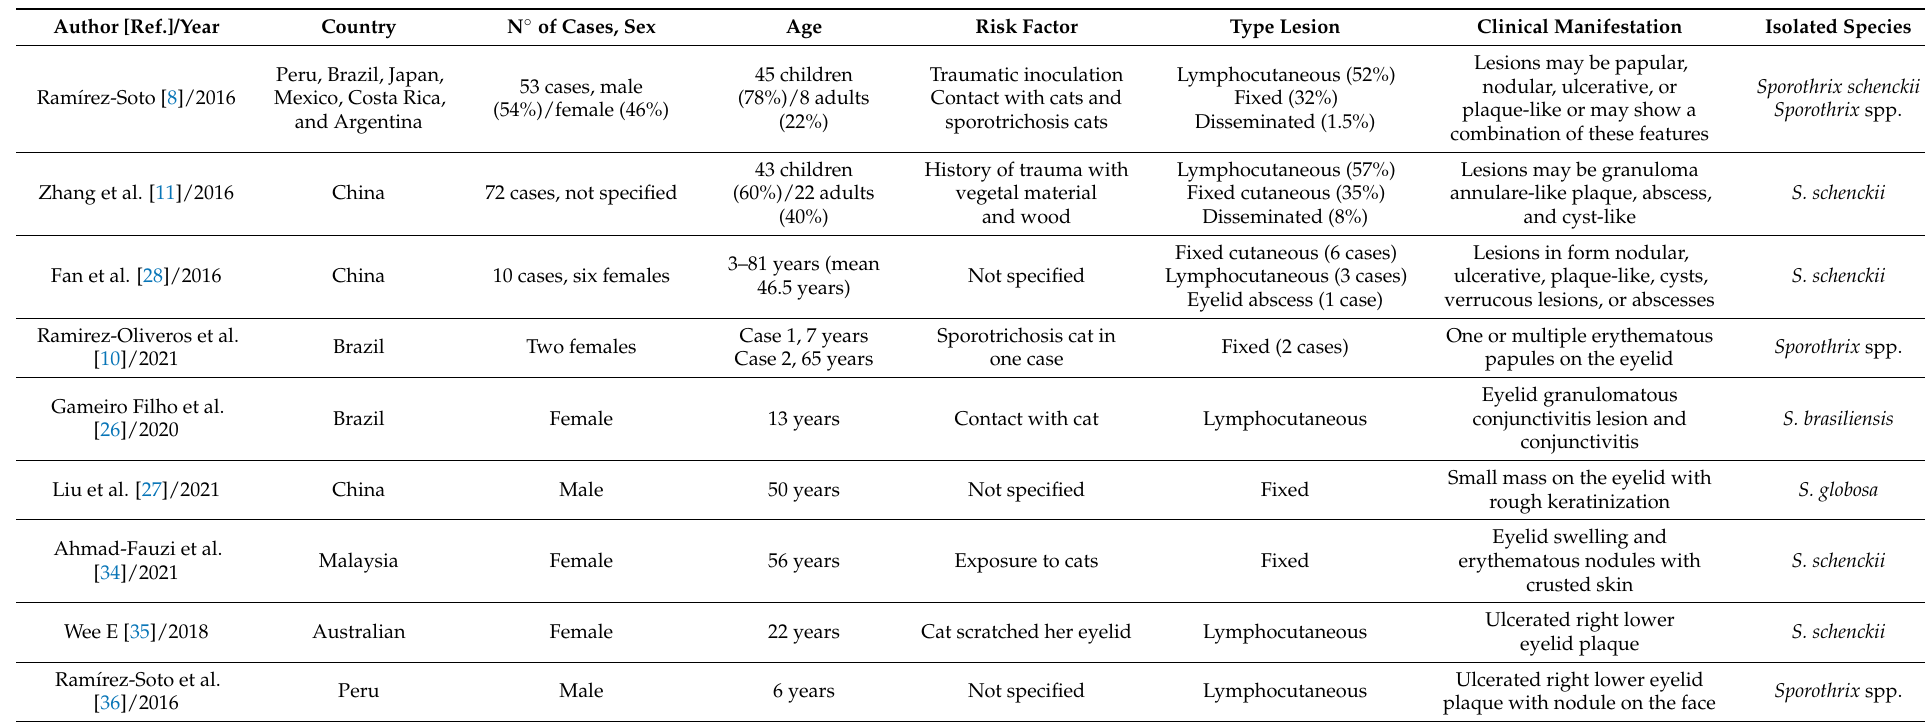
Table 2. Most common eyelid lesions findings in a systematic review, case report, and case series of ocular